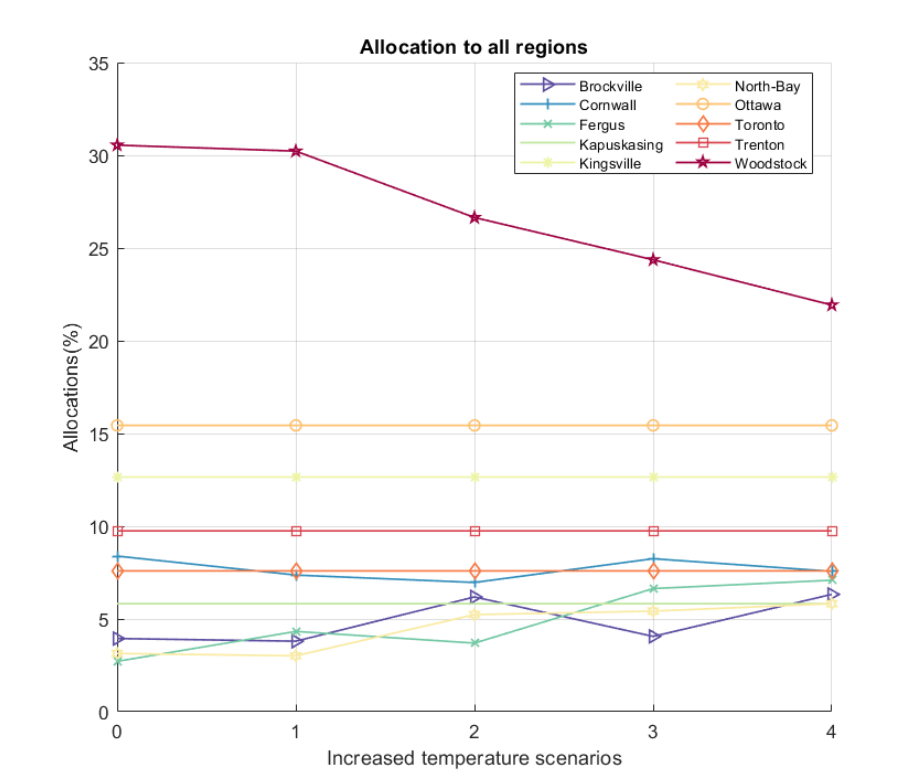
Figure 8. Allocations to each region under five different 1 ◦ C increased temperature scenarios.